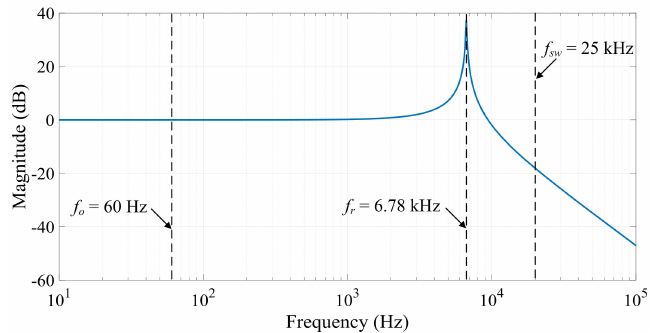
Figure 7. Frequency response of sine